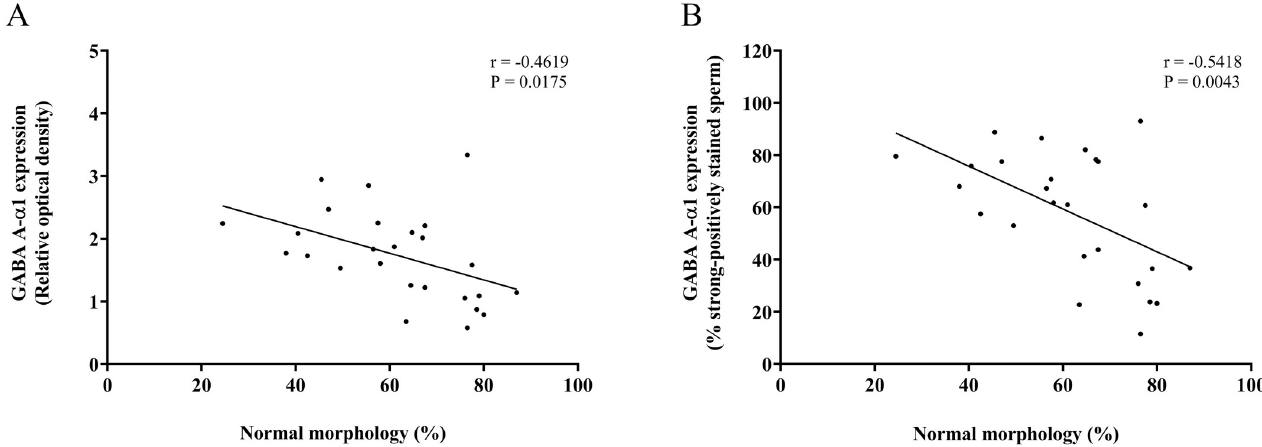
Fig 12. Correlations between the percentage of normal sperm morphology and GABA A- α 1 receptor expression in sperm. (A) Relative optical density. (B) The percentage of strong-positively stained sperm for GABA A- α 1 receptor immunostaining. Linear regression line (black line) fitted to all data points.